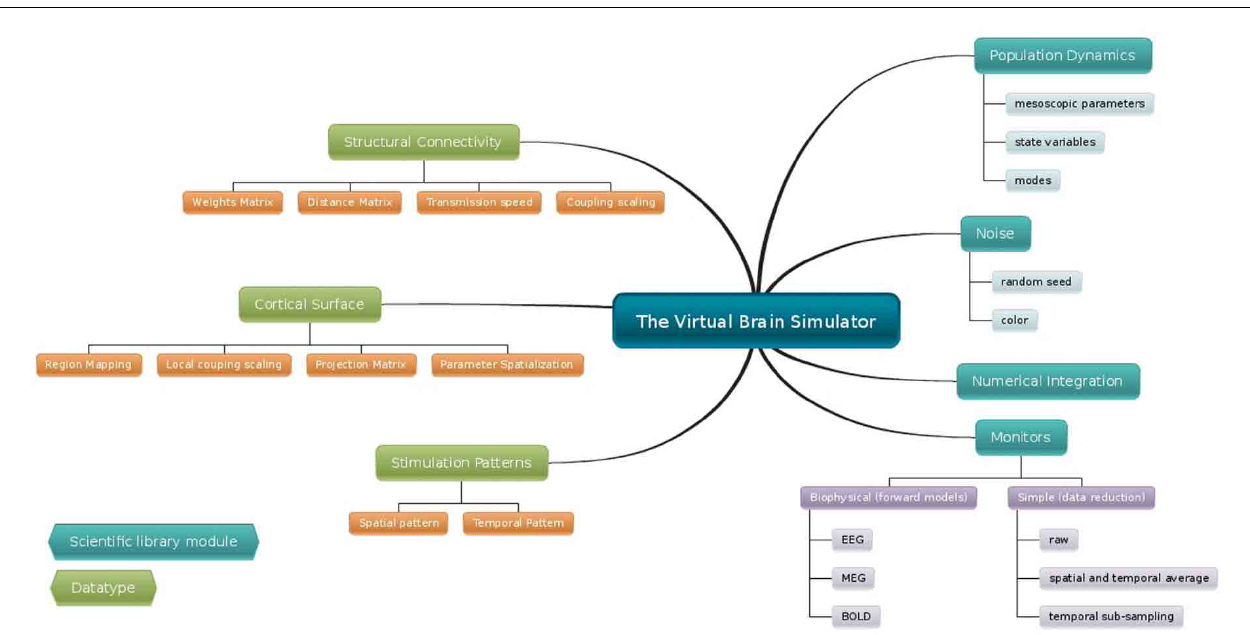
models defining the local dynamics define a full brain network model. Additionally, stimulation can be applied to a simulation. The stimulation patterns are built in terms of spatial and temporal equations chosen independently. For region-based network models, it is only possible to build time dependent stimuli since there is not a spatial extent for a region node. However, node-specific weightings can be set to modulate the intensity of the stimulus applied to each node. For surface-based models, equations with finite spatial support are evaluated as a function of distance from one or more focal points (vertices of the surface), where the equation defines the spatial profile of the stimuli. The neural source activity from both region or surface-based approaches can be projected into EEG, MEG and BOLD (Buxton and Frank, 1997; Friston et al., 2000) space using a forward model (Breakspear and Jirsa,